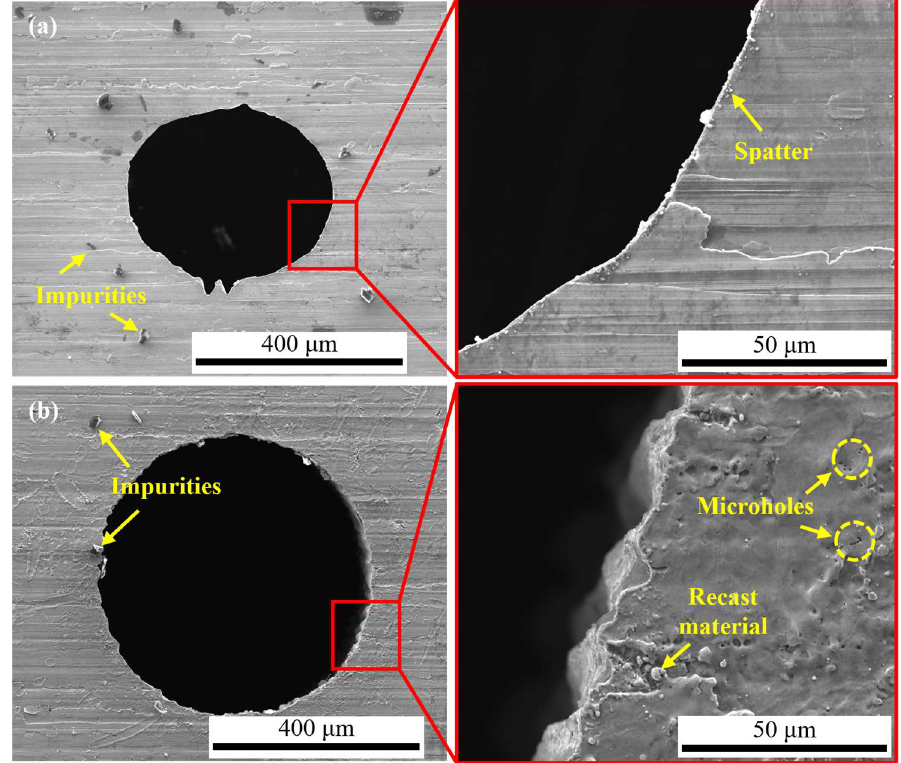
Figure 16. SEM morphologies of the hole exit by laser machining in different conditions. ( a ) Laser machining in the air; ( b ) CWALSM.